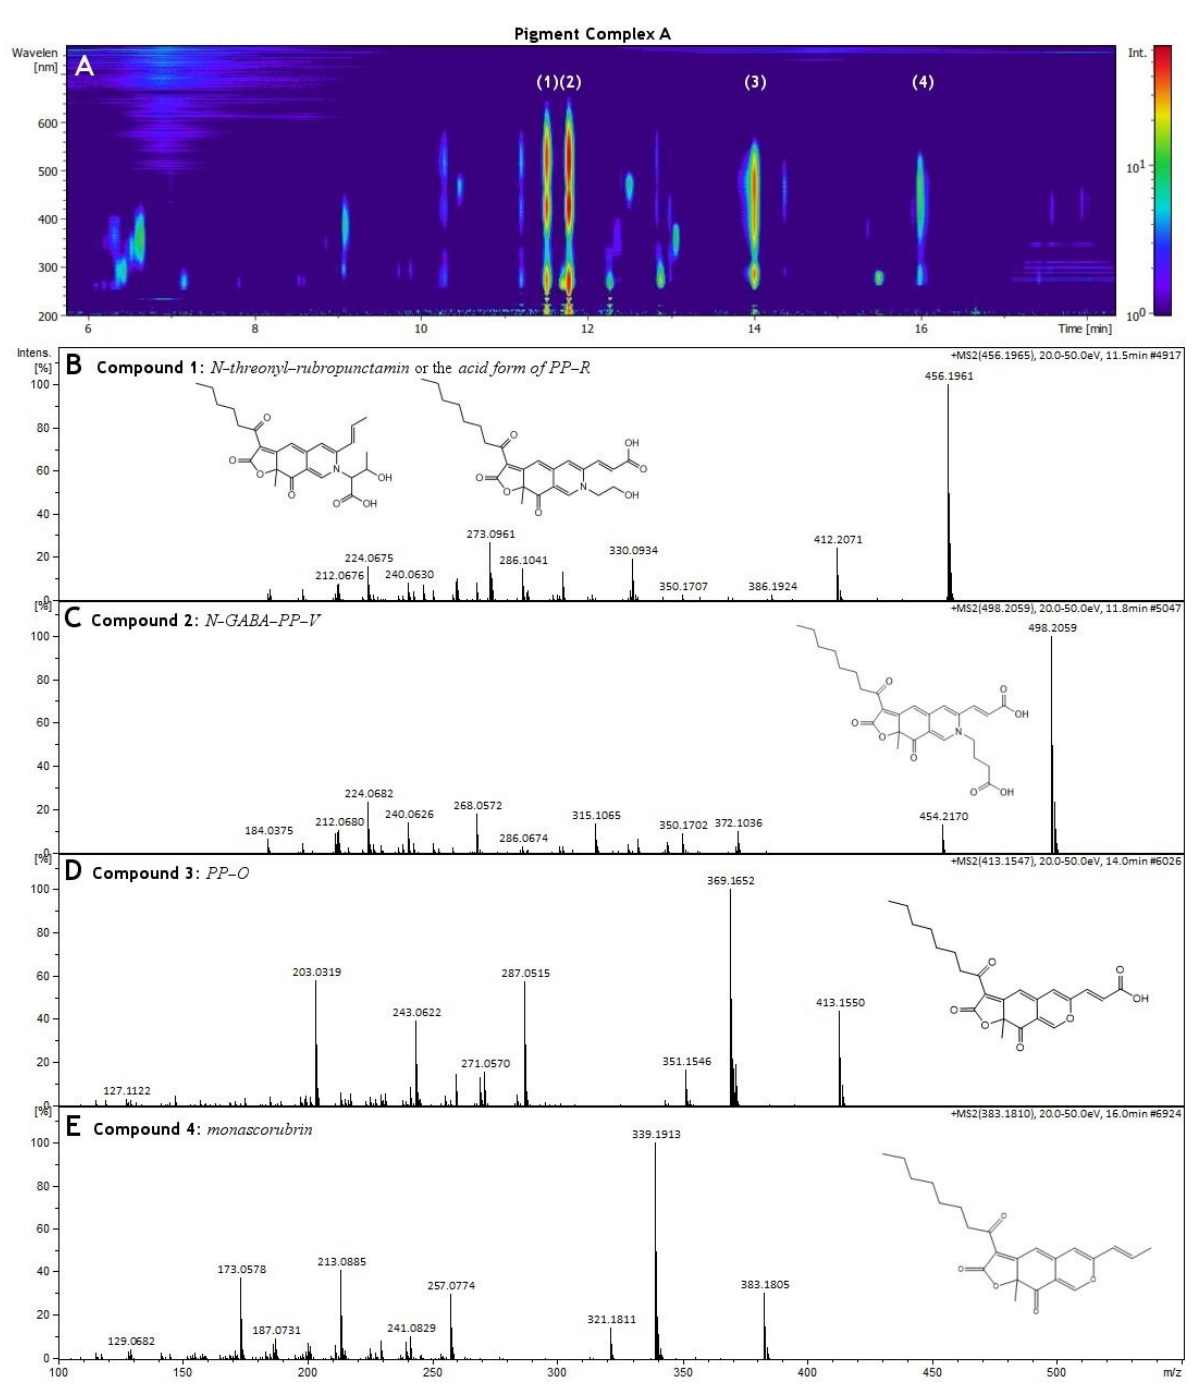
Figure 4. ( A ) Illustration of different compounds (Compound 1 – 4 ) that were detected using UHPLC-DAD chromatography of Pigment Complex A. ( B ) ESI + -MS fragment of Compound 1 ( N-threonyl-rubropunctamin or the acid form of PP-R (purple-red pigments), ( C ) ESI + -MS fragment of Compound 2 ( N-GABA-PP-V or 6-[(Z)-2-Carboxyvinyl]-N-GABA-PP-V), ( D ) ESI + -MS fragment of Compound 3 ( PP-O or (10Z)-12-carboxylmonascorubrin ), ( E ) ESI + -MS fragment of Compound 4 ( monascorubrin) . A second pigment, Compound 2 , at a much lower amount was also identified at